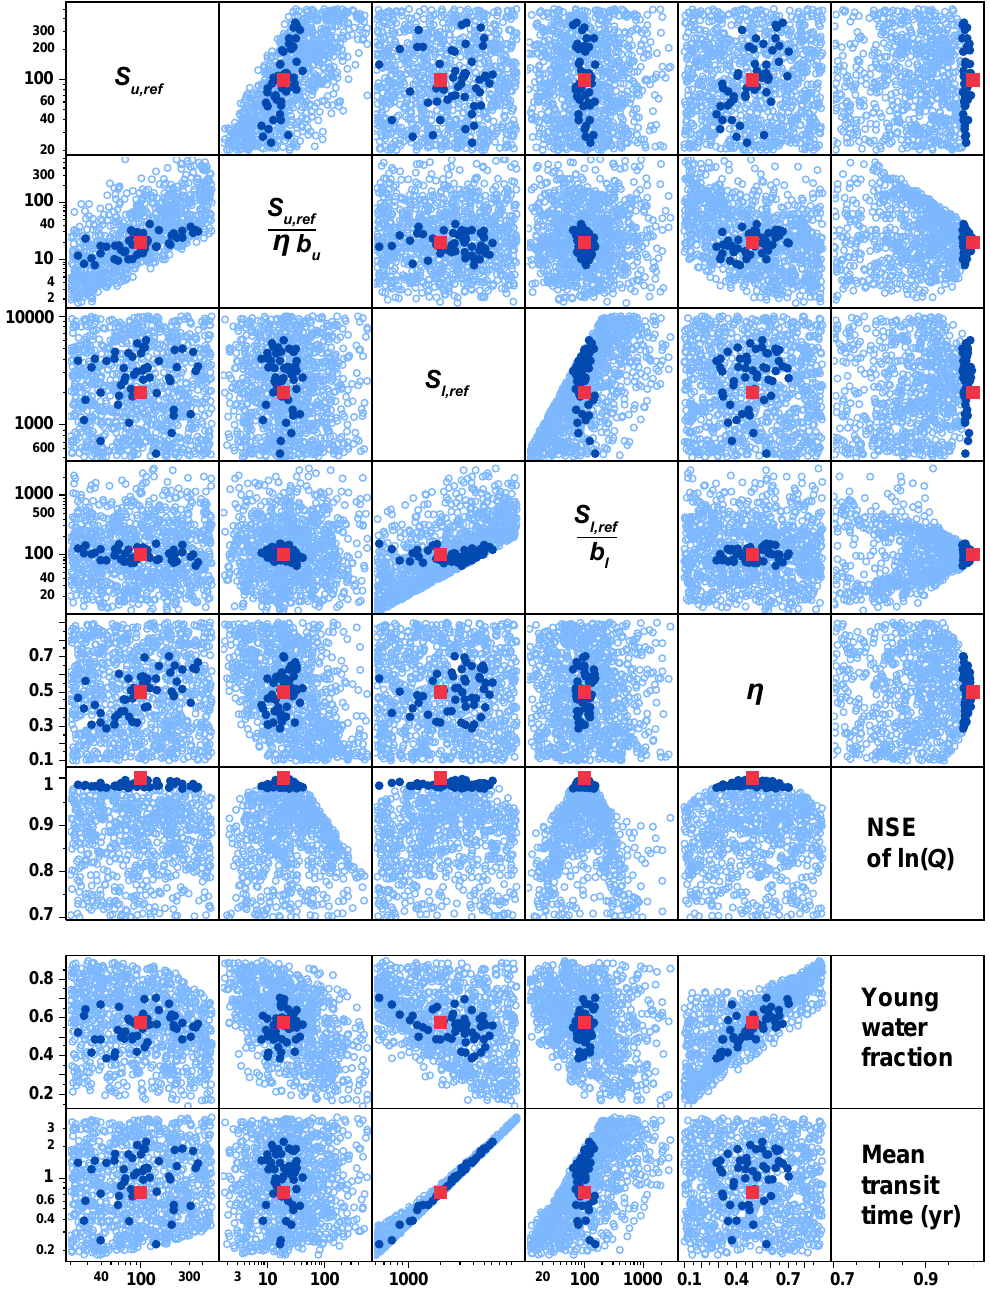
Figure B2. Equifinality partly cured by parameter transformations. The scatterplot matrix shows relationships among 1000 random parameter sets and the NSE of discharge time series driven by Smith River (Mediterranean climate) precipitation forcing, along with two key model outputs, the young water fraction and mean transit time in discharge (bottom two rows). As in Fig. B1, the red square indicates the “reference” parameter set that was used to generate the discharge time series that the other parameter sets were tested against; these reference parameters thus correspond to NSE = 1.00 by definition. The dark blue dots show the best-fitting 50 (or 5%) of the parameter sets, all with NSE ≥ 0.98. In contrast to Fig. B1, three of the five parameters can be constrained by calibration against discharge (as shown by the clear peaks in NSE), and none of the parameters are strongly correlated with one another. However, the two reference storage volumes S u,ref and S l,ref remain poorly constrained. The mean transit time is determined almost entirely by S l,ref , so it cannot be constrained by parameter calibration against the streamflow